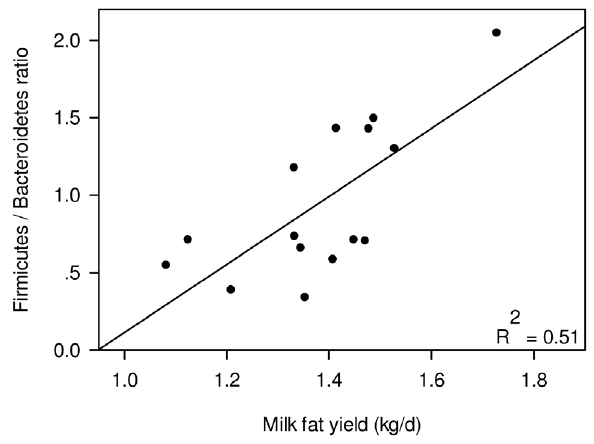
Figure 2. Correlation between milk-fat yield and Firmicutes-to- Bacteroidetes ratio. Scatter plot showing the amount of fat produced per day for each cow (X-axis), vs. the Firmicutes-to- Bacteroidetes ratio. Each point represents one individual cow. R 2 of the linear regression is shown in the upper right corner of the plot.